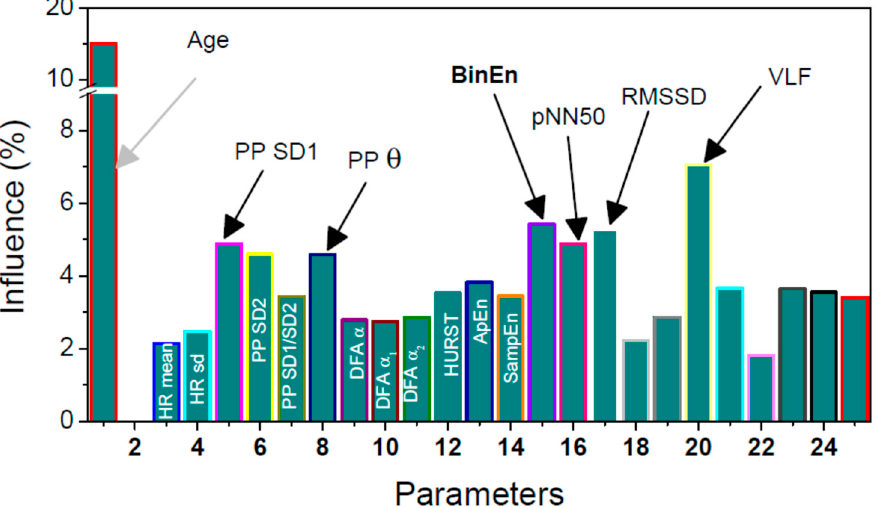
Figure 8. An influence of parameters considering the subject classification. The parameters with significant influence are labelled in black. Parameters 19–25 are related to the power spectral density. Parameter 18 is Total power (sum of the power spectral density components).